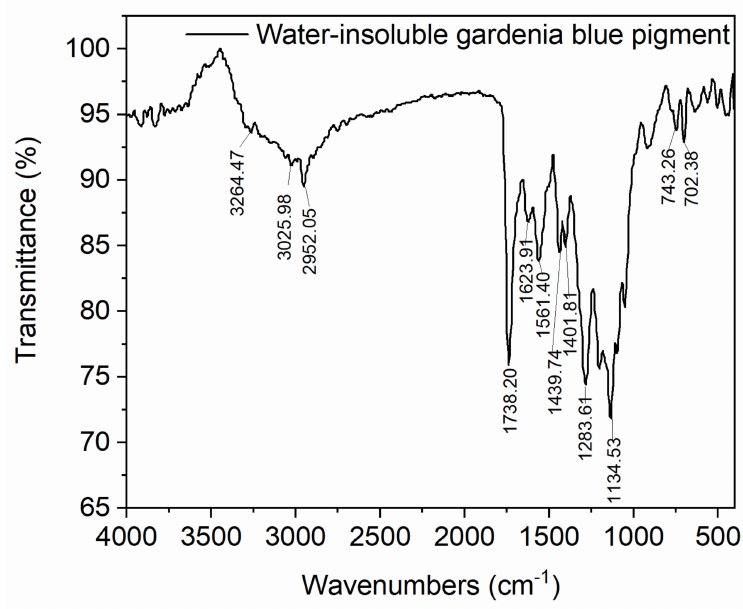
Figure 4. The FTIR of water-insoluble gardenia blue pigment. The results of the full-spectrum XPS of water-insoluble gardenia blue pigment showed that the major elements of water-insoluble gardenia blue pigment are C, N, and O, and the content of C and O are higher than that of N (Figure 5a). The method of separating overlapped curves was adopted to analyze C1s, O1s, and N1s peaks (Figure 5b–d). The contents of the functional groups are in Tables 2–4. The C-1s spectrum of water-insoluble gardenia blue pigment presents main peaks at 284.16 eV, 284.68 eV, 286.09 eV related to Sp2 hybrid, C=C, and C-O structures. The O-1s spectrum of water-insoluble gardenia blue pigment presents two peaks at 531.95 eV and 533.47 eV related to O-C and O=C structures. The N-1s spectrum of water-insoluble gardenia blue pigment presents two peaks at 402.24 eV and 400.57 eV related to C-N-C and C-N structures. As a result, XPS shows that water-insoluble gardenia blue pigment has a π - π * resonance system, and functional groups are O-C=O, C=O, COOC, C-N, C=C, and benzene